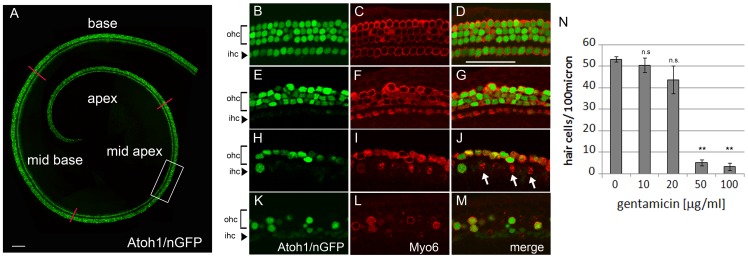
Gentamicin exposure results in rapid inner and outer hair cell loss.
A: Acutely isolated cochlear explant (stage P2). Atoh1/nGFP expression (green) labels inner and outer hair cell nuclei. Red lines subdivide auditory sensory epithelium into apex, mid apex, mid base and base. Scale bar 100 μm. B–M: Hair cell phenotype 24 hours after exposure to various concentrations of gentamicin. Confocal images are taken from the central part of mid apical segment (A, white box). Brackets mark outer hair cell domain (ohc), arrowheads point to inner hair cell domain (ihc). Myosin VI antibody staining (Myo6, red) labels cytoplasmic domain of hair cells. Atoh1/nGFP transgene (green) labels hair cell nuclei. Scale bar 50 μm. B–D: control (0 μg/ml gentamicin). E–G: 10 μg/ml gentamicin. H–J: 50 μg/ml gentamicin. White arrow marks Myo6 positive hair cell debris. K–M: 100 μg/ml gentamicin. N: Quantification of B-M. Hair cell numbers were analyzed in the mid apical segment. Data expressed as mean ±SEM (n = 3 cochlear explants from 2 independent experiments; ** p≤0.0001, Student's t-test; p>0.05 was considered not significant (n.s.)).